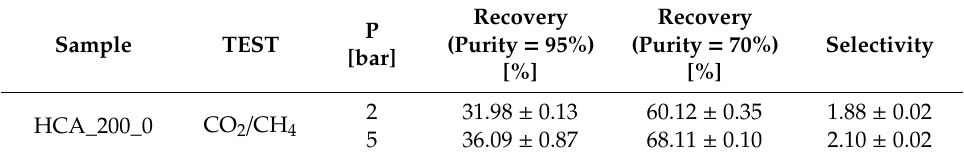
Table 4. Summary of the results of the adsorption tests (mixture CO 2 / CH 4 ).